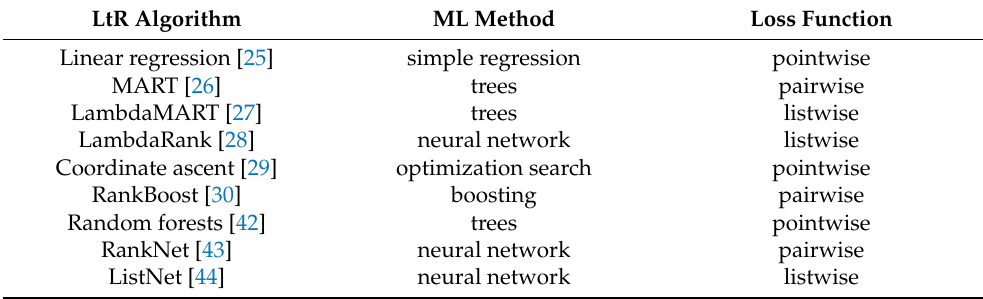
Table 3. The considered LtR algorithms with their corresponding ML models and loss function. LtR Algorithm ML